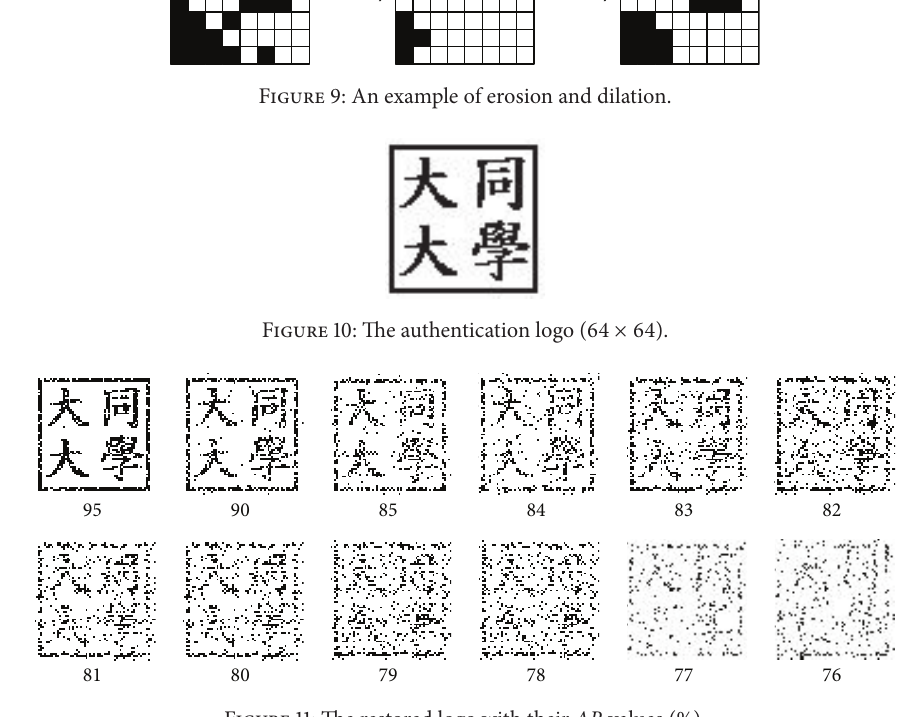
Figure 11: The restored logo with their AR values (%).